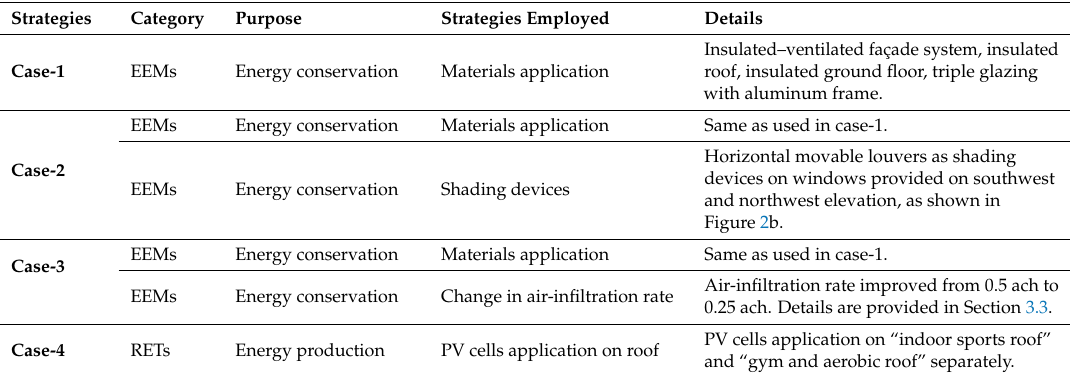
Table 1. Energy conservation